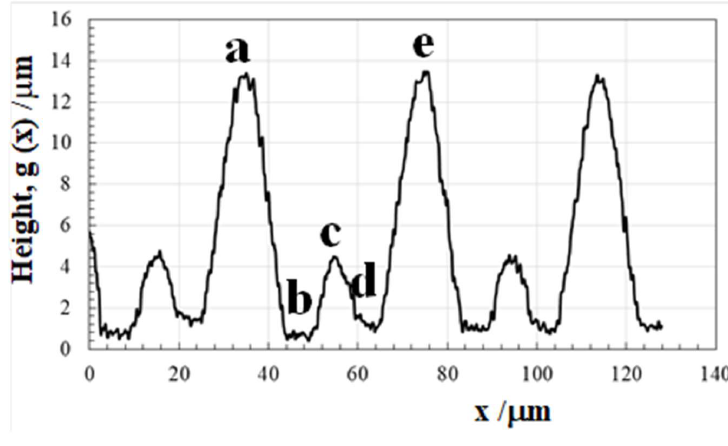
Figure 4. One-dimensional surface profile, selectively processed from the two-dimensional scanning electron microscope (SEM)